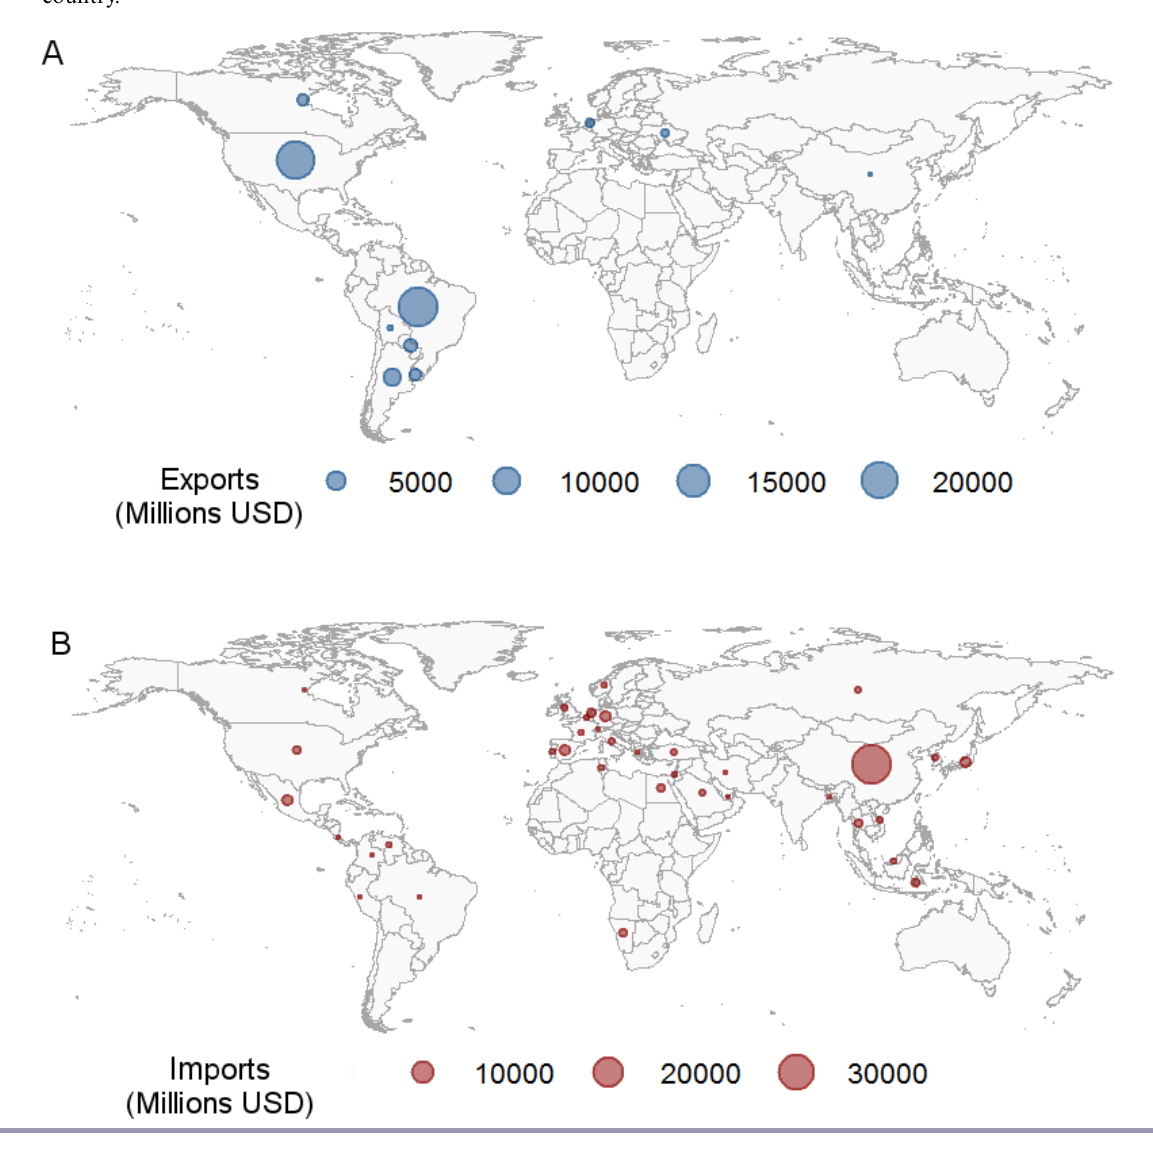
Fig. 2 . Distribution of (A) soybean sending and (B) soybean receiving systems in the soybean metacoupled system, where countries were ranked in terms of export value (millions US$) of soybean sent or received by each